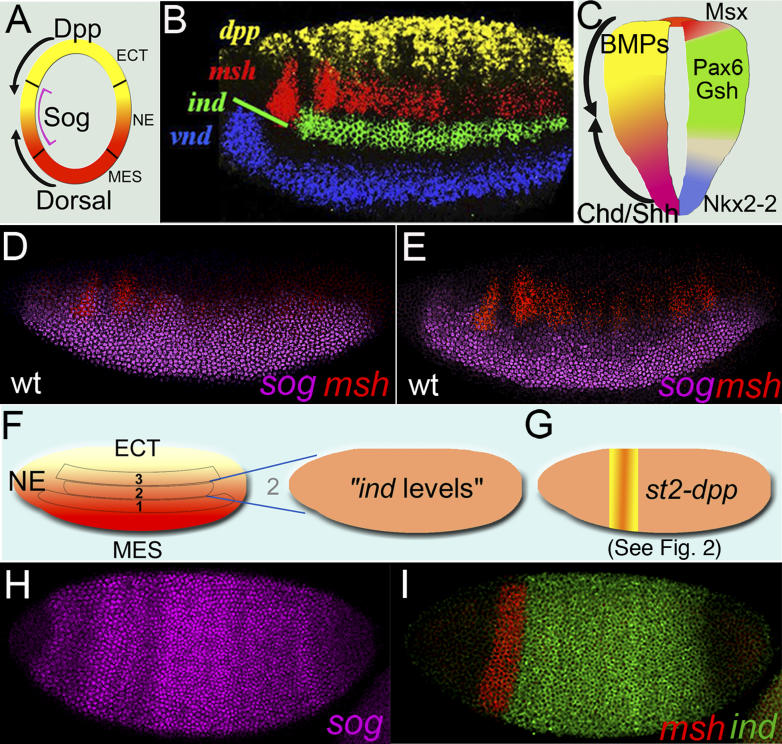
A Conserved Pattern of Gene Expression in the Neuroectoderm(A) Diagram indicating the relative positions of opposing BMP and Dorsal gradients in a transverse cross-section of a blastoderm stage Drosophila embryo.(B) Multiplex in situ staining of a Drosophila blastoderm stage embryo showing expression of vnd, ind, msh, and dpp along the DV axis. Dorsal is to the top and anterior to the left in this and subsequent figures.(C) Scheme indicating the relative expression domains of Nkx2.2, Gsh, Pax6, Msx1/2 as well as the BMP and Shh protein gradients in the vertebrate neural tube.(D and E) Dynamics of sog expression (purple) and msh expression (red).(D) In mid-blastoderm stage embryos, sog expression begins to fade from most dorsal cells of the neuroectoderm at the same time that msh expression is initiated as a partial stripe.(E) In slightly later embryos, the domains of sog and msh expression become nearly complementary.(F) Scheme for generating lateralized embryos with a uniform level of Dorsal adjusted to the level present in the mid-neuroectoderm (e.g. ind-expressing cells). These embryos were collected from females of the genotype gd
7
sog
U2/gd
7
; dl
1/+; Tl
3/+.(G) The same females were crossed to males carrying a homozygous insertion of an st2-dpp construct [75] to generate lateralized embryos expressing dpp in a stripe (see Figure 2).(H and I) Expression of neuroectodermal genes in lateralized embryos. (H) sog (purple). (I) ind (green) and msh (red). Note that the ring of msh expression directly abuts the domain of ind with no overlap and extends anteriorly beyond the domain of ind expression to approximately the same extent as observed in wild-type embryos (see [B]).